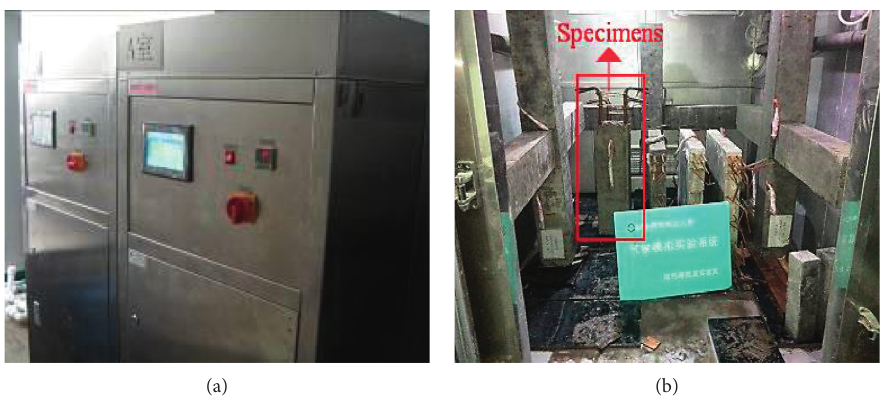
Figure 2: Photographs of the environmental chamber. (a) Exterior. (b) Interior.